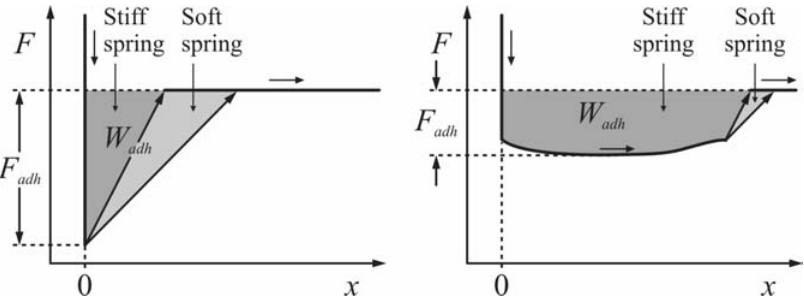
Fig. 9 Schematic of retracting force-versus-distance curves in the case of contact (left) and bridging adhesion